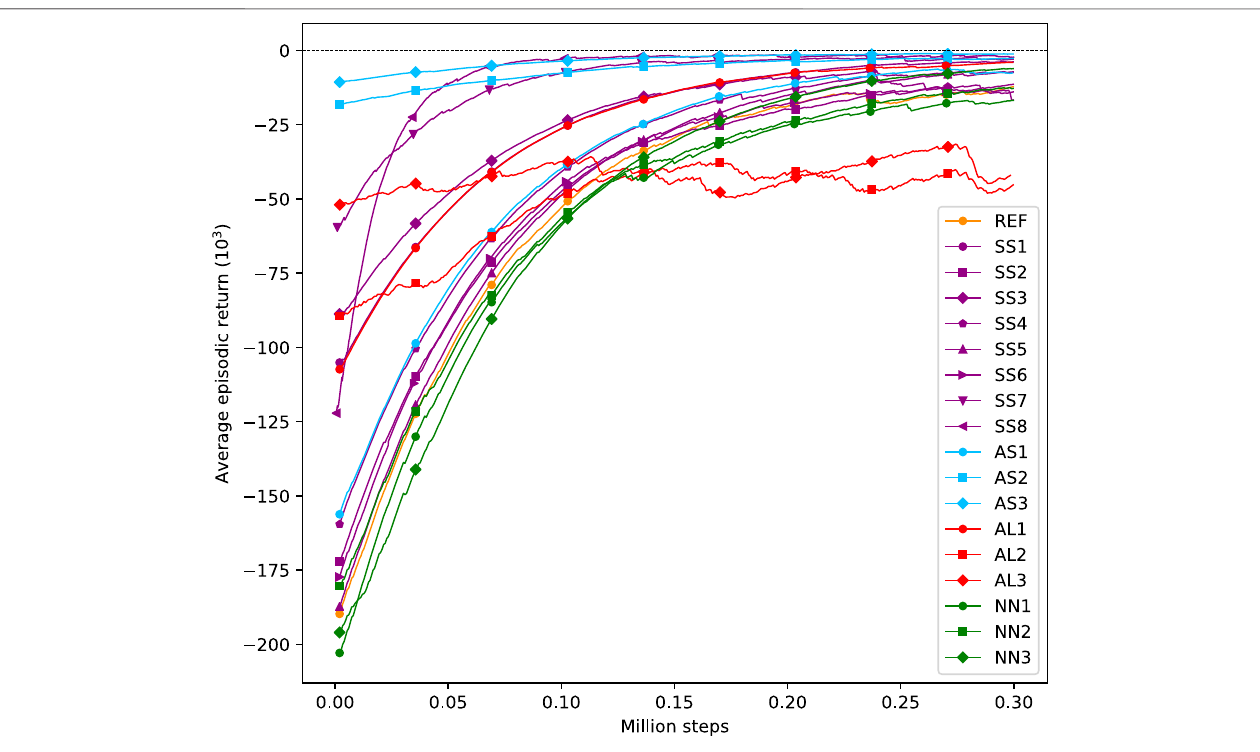
Frontiers in Built Environment |